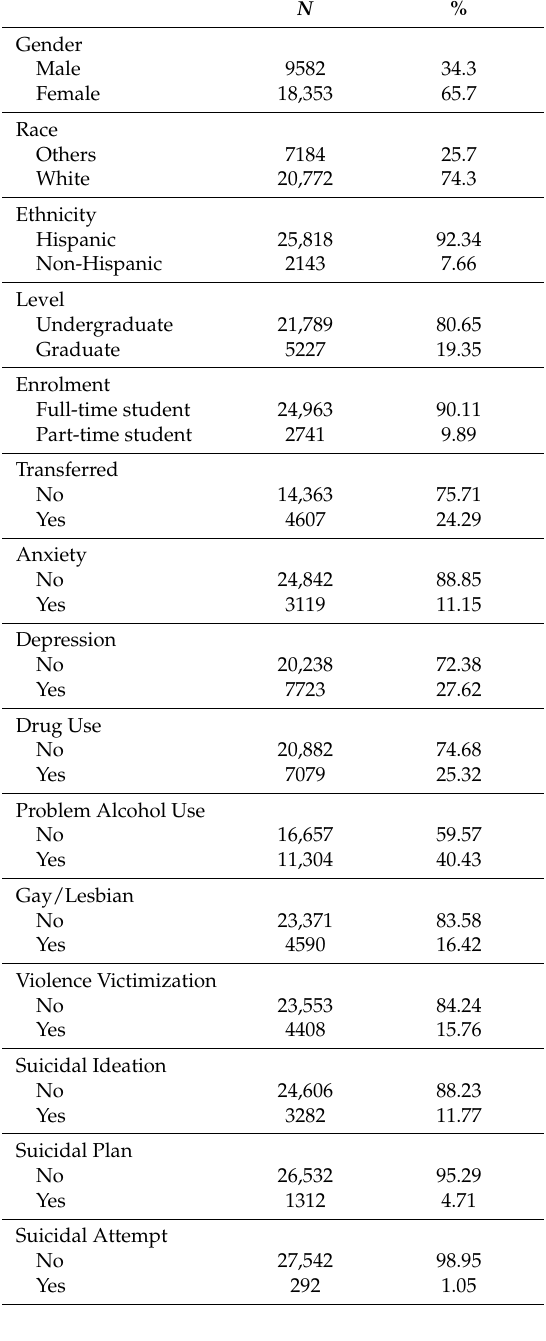
Table 1. Descriptive characteristics in the